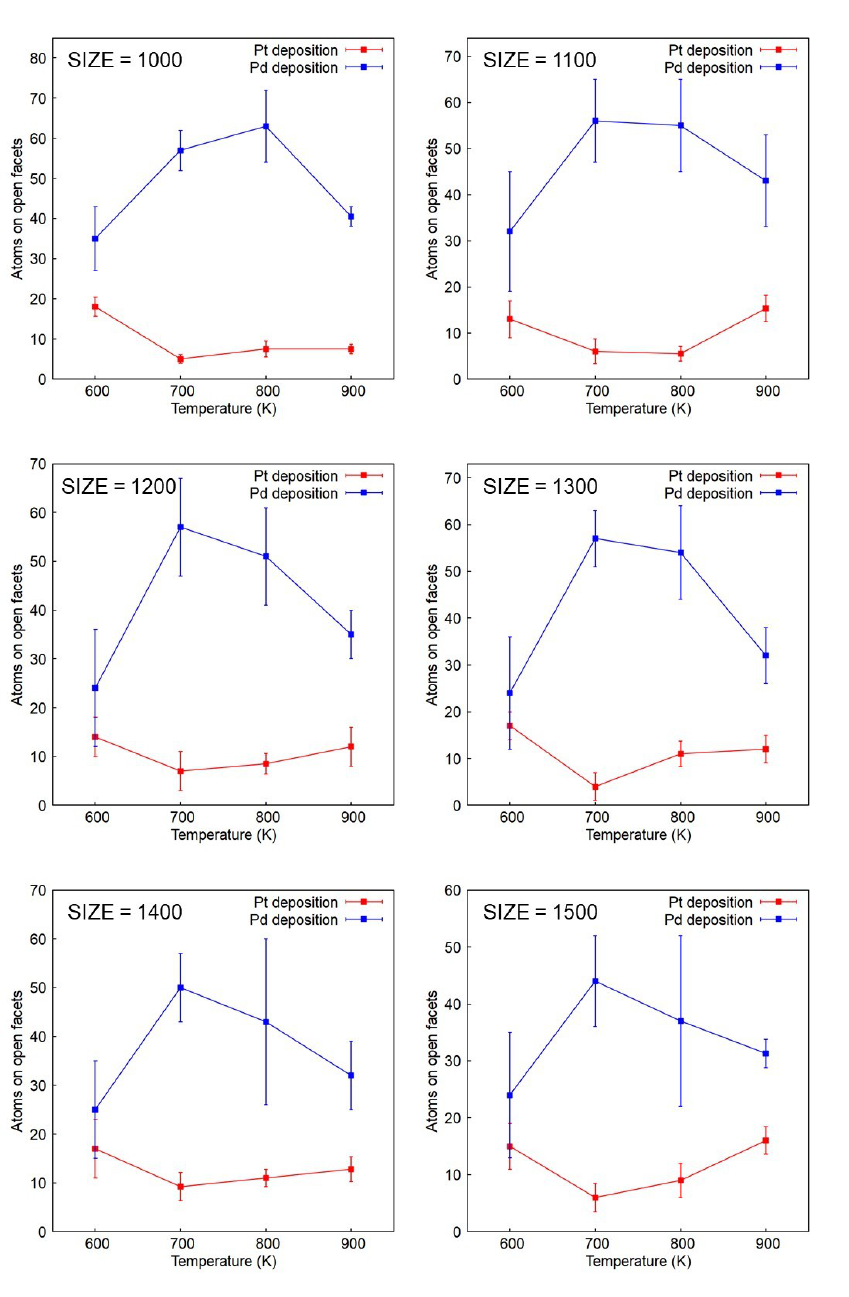
Figure 6. Number of atoms on open facets in the growth simulations at different temperatures and sizes. Results were obtained by averaging over four independent